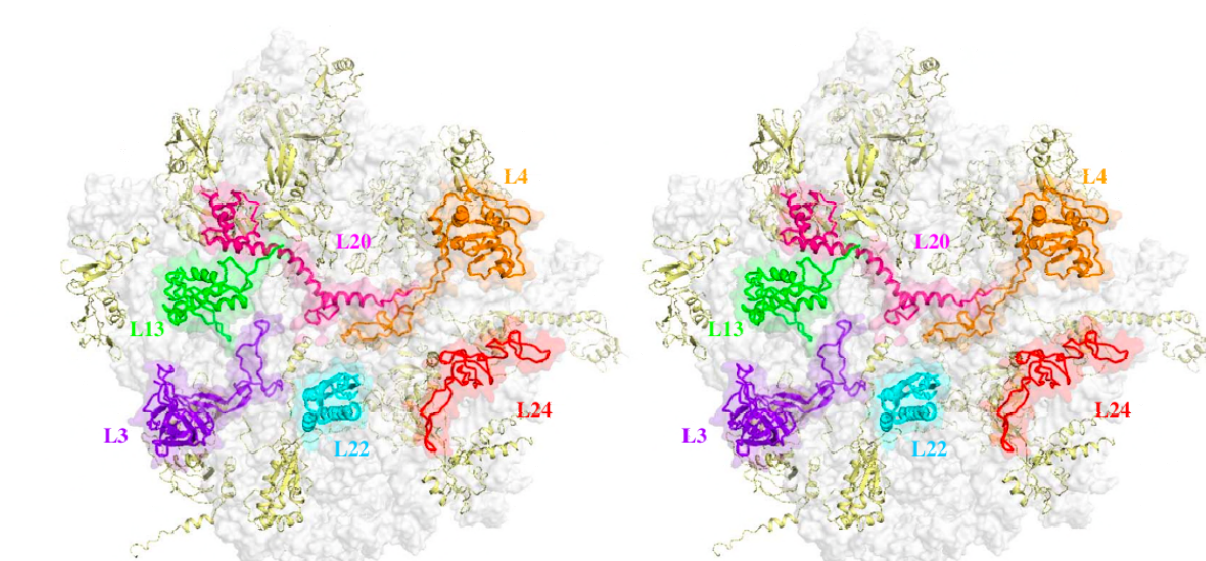
Figure 1. Stereo view of the large subunit of T. thermophilus [14] showing the distribution of the six ribosomal proteins L3 (purple blue), L4 (orange), L13 (green), L20 (magenta), L22 (cyan) and L24 (red) essential for the formation of the first reconstitution intermediate in vitro